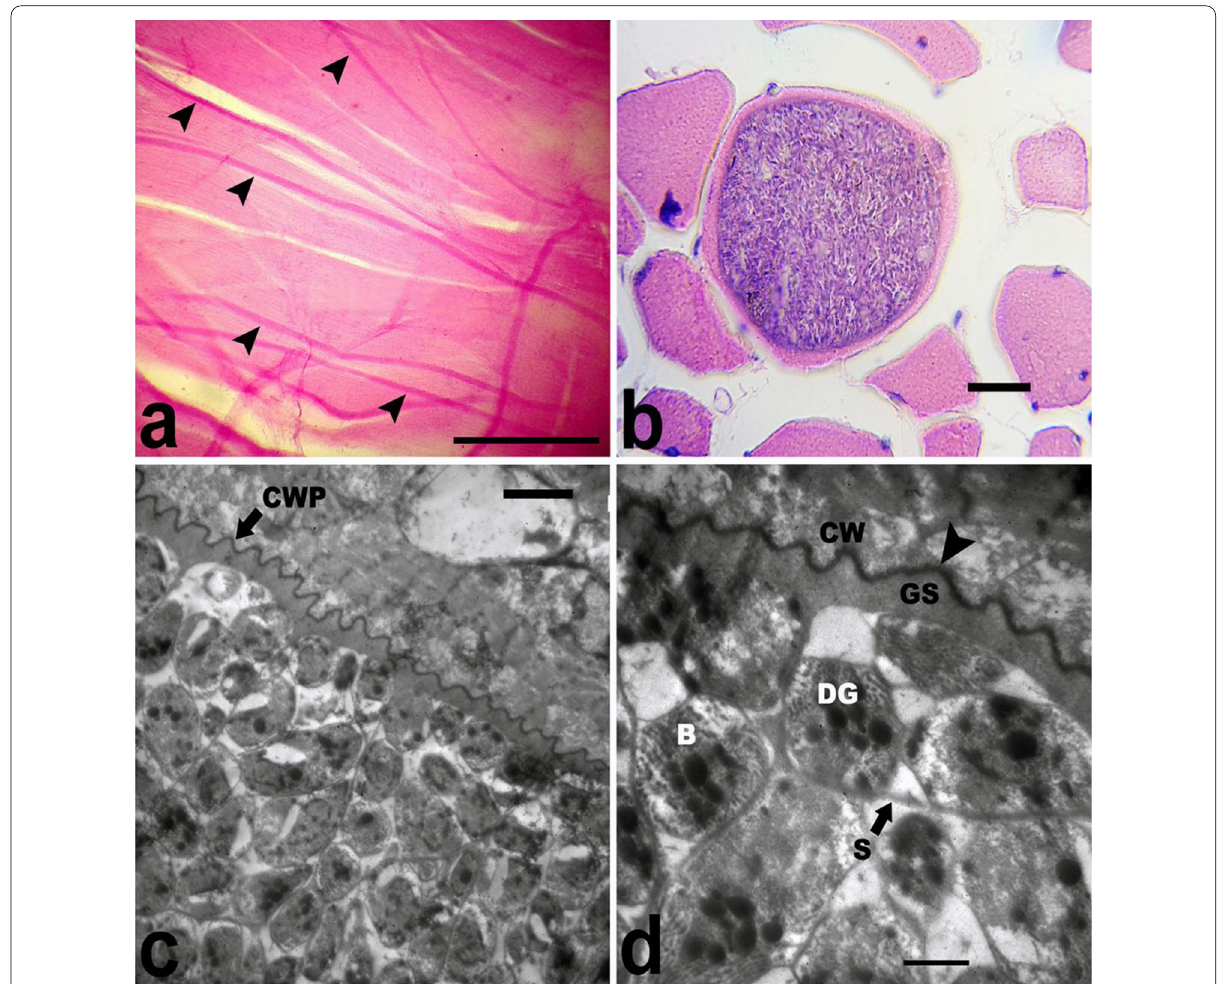
Fig. 1 Sarcocystis sp. obtained from the little grebe, Tachybaptus ruficollis . a A wet mount from esophageal muscles infected with sarcocysts stained with potassium alum carmine. Note the heavy infection with numerous ribbonlike sarcocysts (arrowheads). Scale bar of a thin‑walled Sarcocystis sp. sarcocyst in a hematoxylin and eosin (HE)‑stained histological section. Scale bar microscopy (TEM) image of Sarcocystis sp. showing zigzag‑like or undulating vacuolar membrane with villar protrusions (VP) of slightly variant sulci and gyri. Scale bar 1 µm. d A higher magnification of the TEM image reveals a cyst wall (CW) with several bleb‑like protrusions (arrowhead), = ground substances (GS), fragments of bradyzoites (B) with dense granules (DG) and septa (S). Scale bar